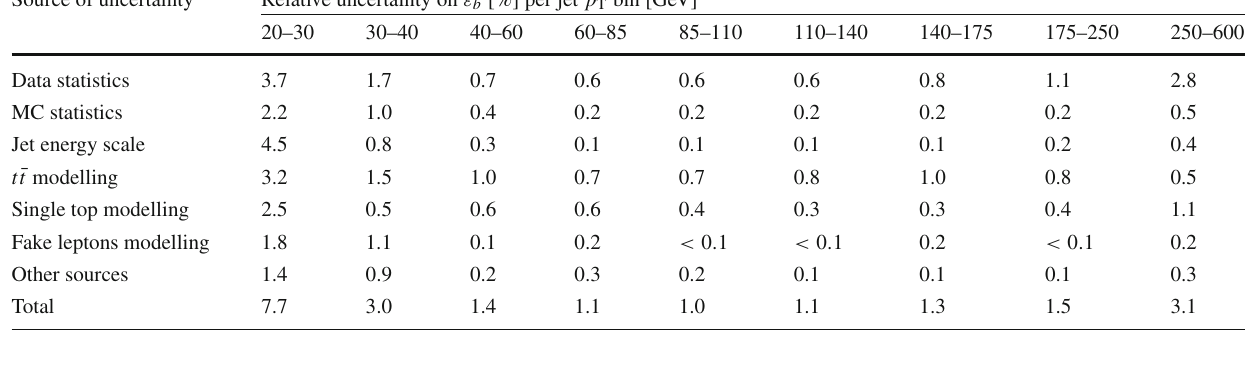
Table 5 Breakdown of the systematic uncertainties in the b -jet tagging efficiency measurement for the 70% single-cut OP of the MV2 tagger as a function of the jet p T bin. The ‘ t ¯ t modelling’ and the ‘Single top modelling’ uncertainties correspond to the sum in quadrature of the uncertainty in the parton shower, hadronisation model, initial-state and final-state radiation and PDF for t ¯ t and single top-quark production, respectively. The ‘Single top modelling’ uncertainties include an addi- tional source originating from the interference between single top and t ¯ t production. ‘Other sources’ corresponds to the sum in quadrature of